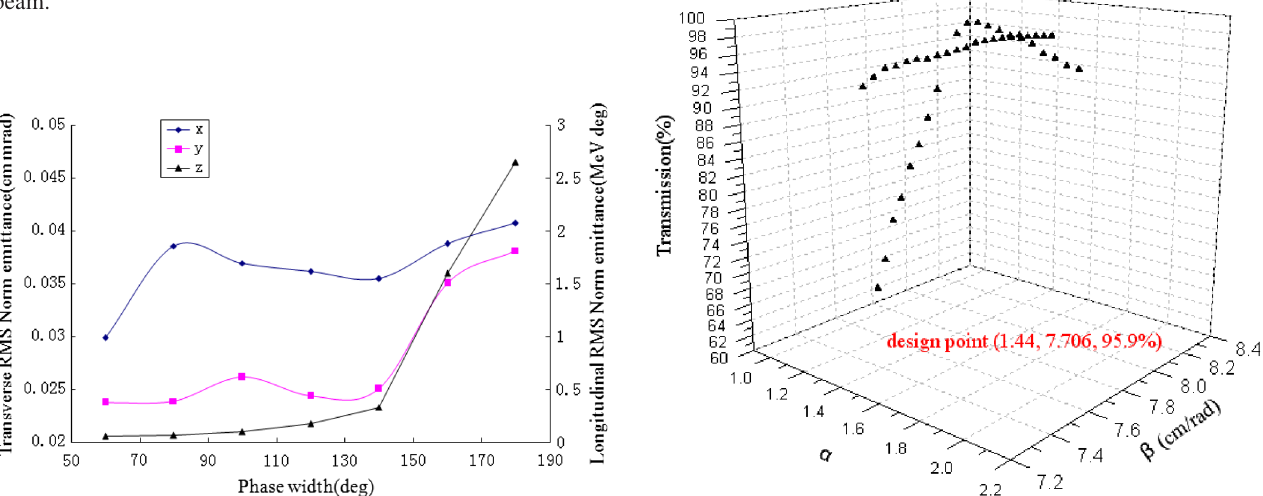
FIG. 15. Transmission for different phase widths of the input beam.